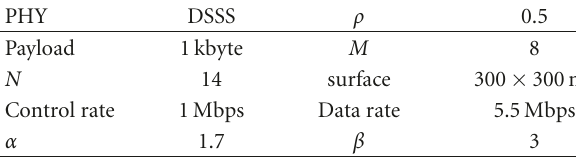
Figure 3: Throughput comparison of the random scenario, ρ = 0.5.